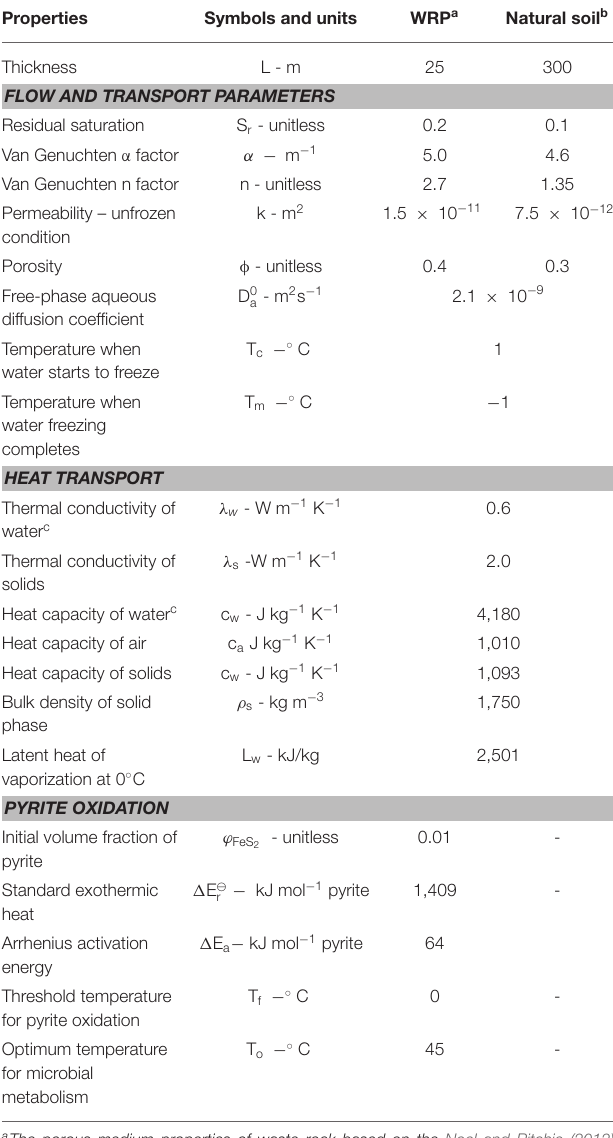
TABLE 1 | Parameterization of 1D and 2D waste rock THC